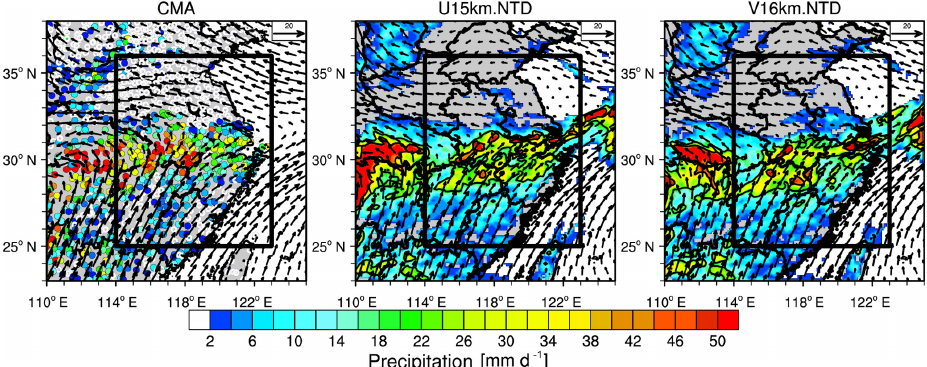
Figure 2. Spatial distributions of precipitation and wind fields at 850hPa averaged during the event (25 June 00:00 to 27 June 12:00UTC) from the simulations with global uniform (15km) and variable (16km over the refined region as shown in Fig. 1c) resolutions. The observed mean precipitation from the CMA stations and the wind fields from the ERA5 reanalysis are shown. The black contour lines represent precipitation larger than 20mmd − 1 . The black box denotes the region of East China (25–36 ◦ N, 114–123 ◦ E) for the analysis in the following.